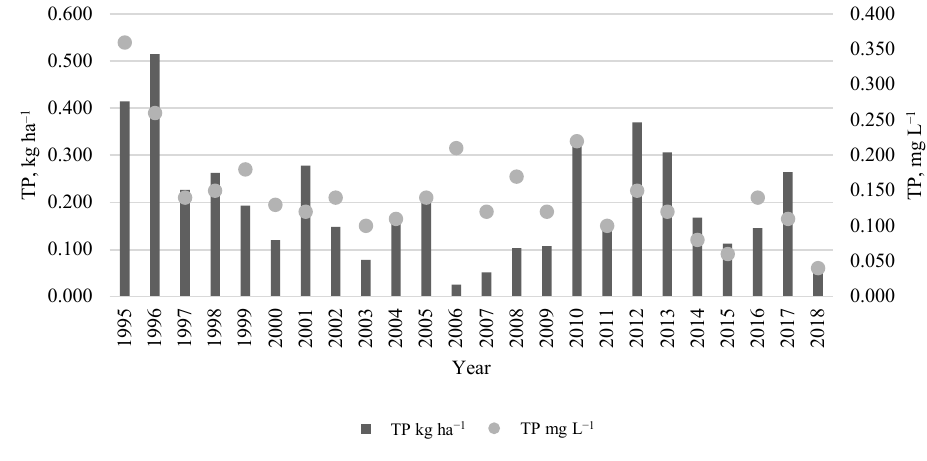
Fig. 3. Annual losses (kg ha –1 ) and concentrations (mg L –1 ) of total phosphorus (TP) in the Berze small